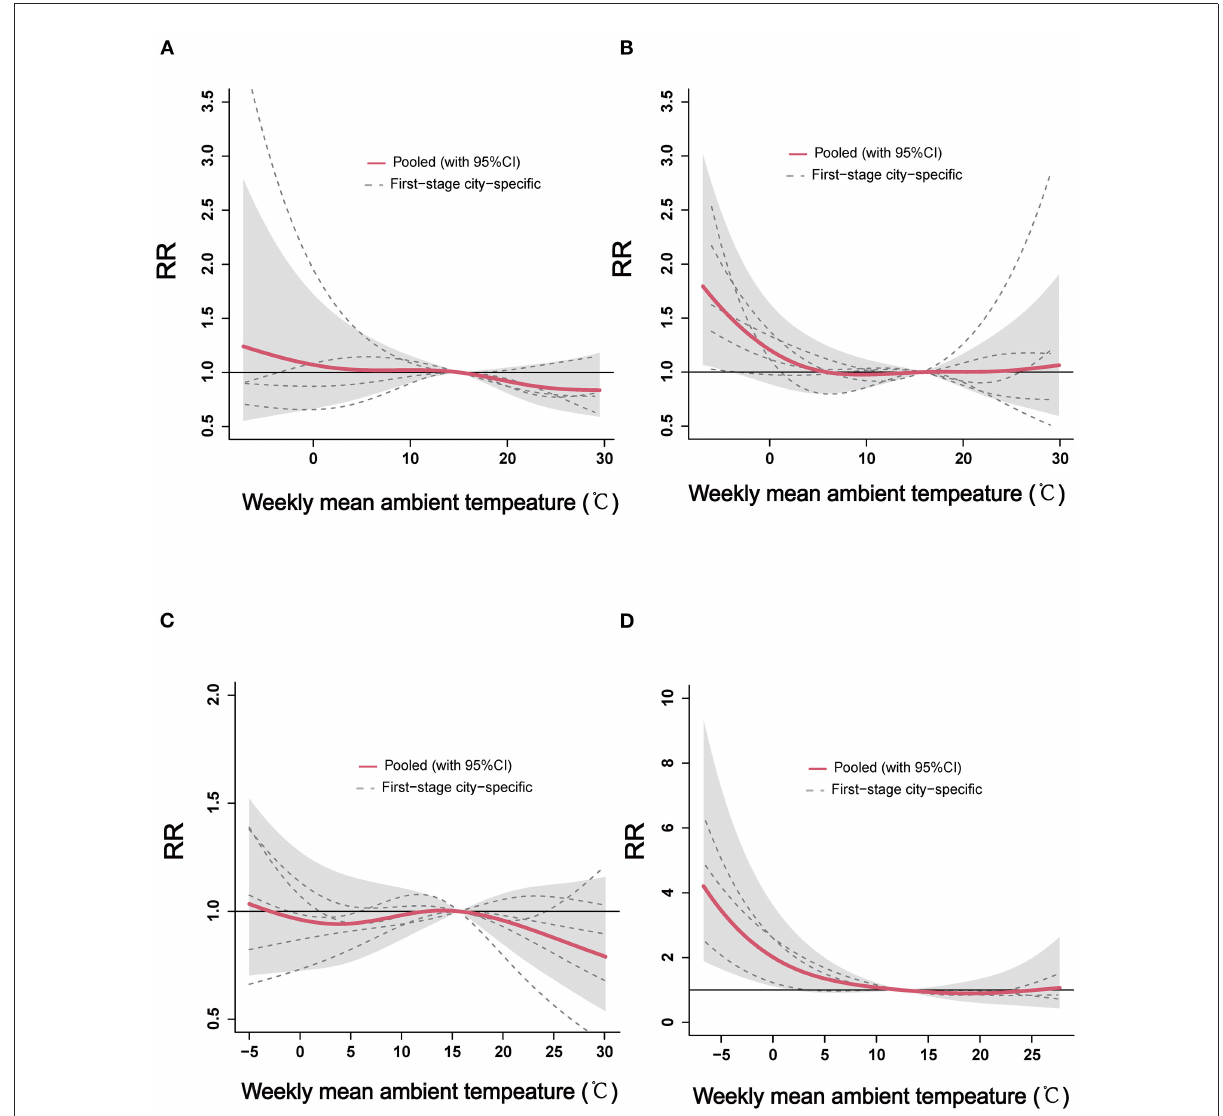
FIGURE3 The region-specific pooled estimates of weekly mean ambient temperature on ILI in the four regions of Shandong Province. ILI, influenza-like-illness; RR, relative risk. (A) North Shandong, (B) Central Shandong, (C) South Shandong, and (D) Jiaodong